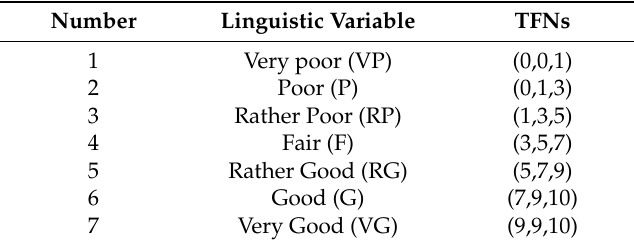
Table 4. Linguistic scale for alternatives ranking